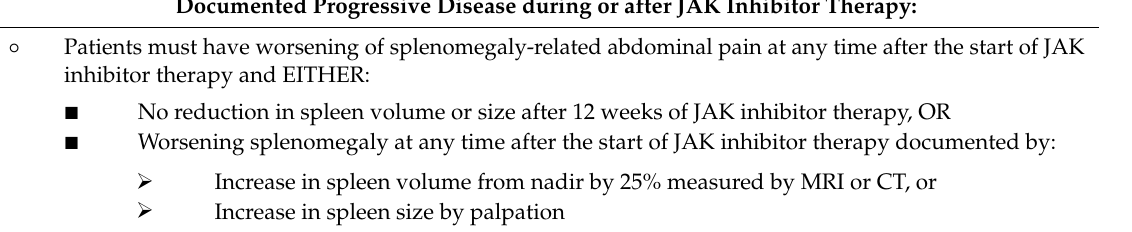
Table 1. Definition of myelofibrosis (MF) relapsed / refractory to JAK inhibitor therapy in the IMBARK ™ trial